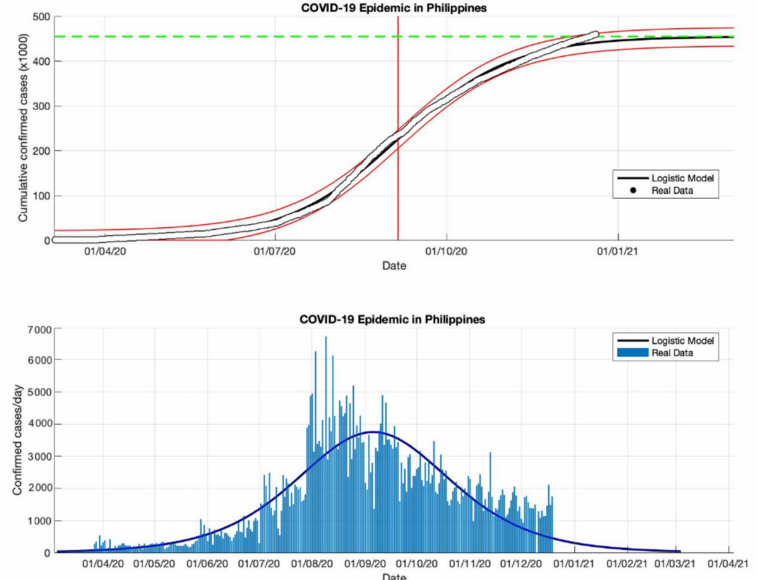
Figure 15. In the above figure, the prediction results of the logistic growth model for cumulative infected cases are compared with the actual data, while the two red lines between the black lines represent a prediction error limit of about 5%. The dashed green line predicts the total size of infected cases in the final phase of the epidemic. The red line intersects the cumulative case curve to predict the turning point or peak point of the epidemic (this line is parallel to the top of the curve from the below figure). In the below figure, the prediction results of this model for daily infected cases in